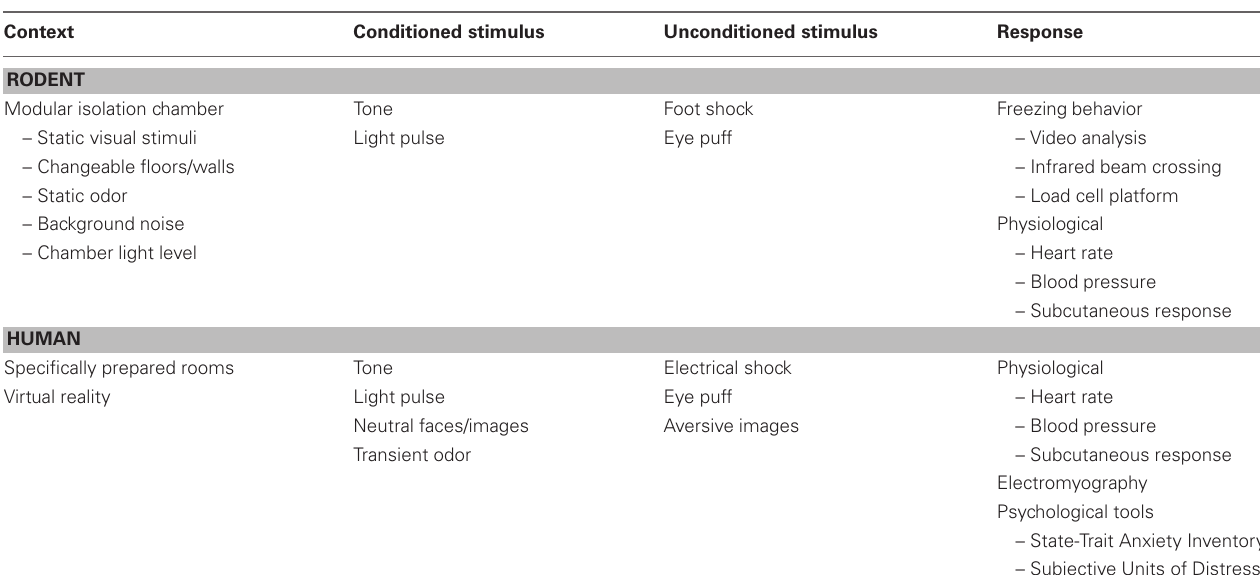
Table 1 | Basic parameters for fear conditioning in rodents and